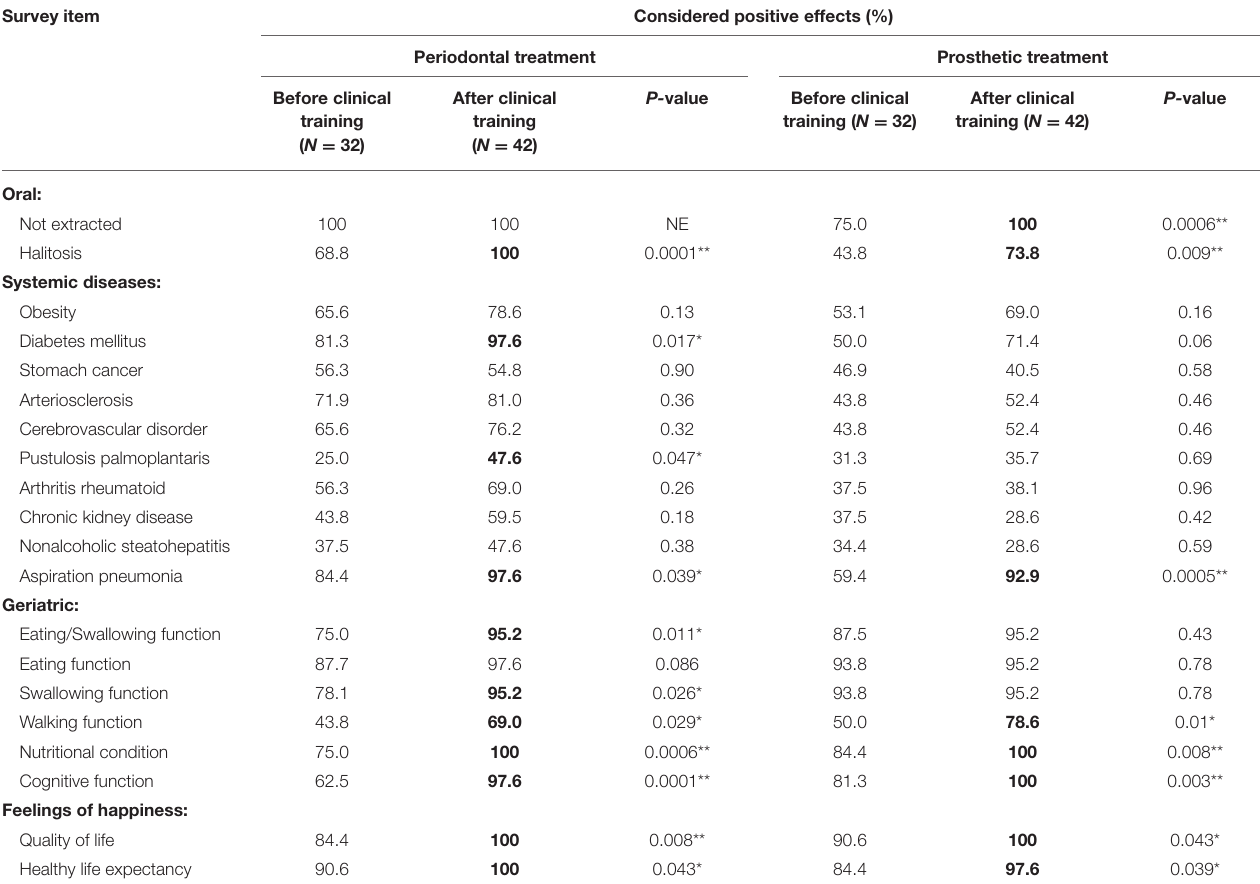
TABLE 2 | Changes in awareness of dental students after clinical training about the effects of periodontal or prosthetic treatment on diseases, symptoms, and conditions. Survey